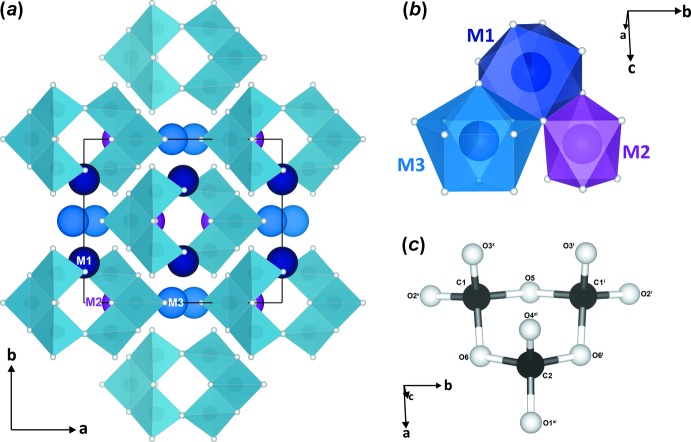
(a) The crystal structure of (Mg2.53Fe0.47)C3O9 according to this study, in a projection along the c axis; CO4 tetra­hedra are given in the polyhedral representation. (b) The three cation sites that host Mg/Fe atoms and their respective polyhedra. (c) C3O9
6− ring anions are formed from three edge-sharing CO4 tetra­hedra. Atomic positions are shaded according to colours in (b) and oxygen atoms appear as small white spheres. [Symmetry codes: (i) x, −y, z; (v) −x + , −y + , −z + 1; (x) −x, y, −z + 1; (xi) x, y, z + 1.]